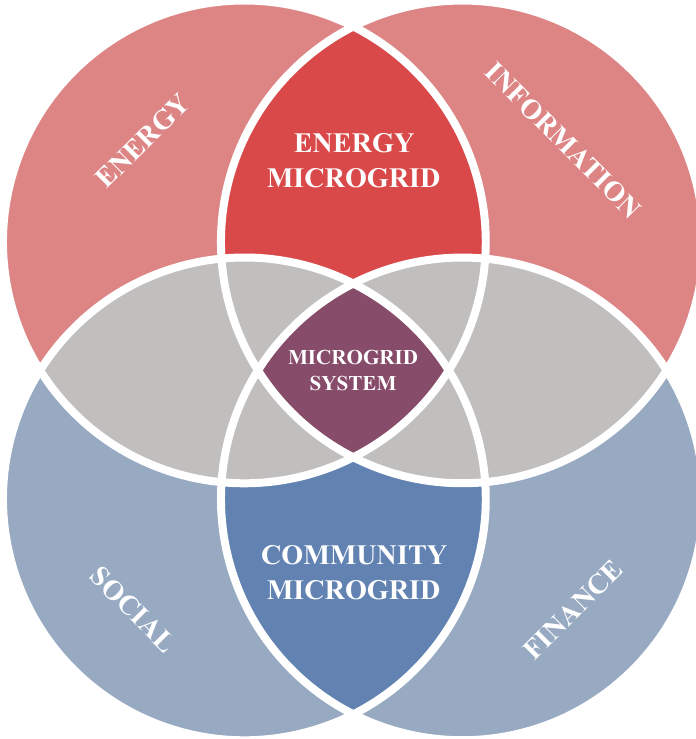
Figure 2. The two definitions of microgrids and their